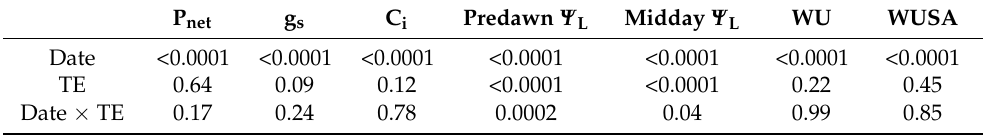
Table 3. Statistical significance for the effects of date and throughfall exclusion (TE) on leaf-level net photosynthesis (P net ), stomatal conductance (g s ), intercellular CO 2 (C i ), predawn leaf water potential ( Ψ L ), midday leaf water potential ( Ψ L ), whole-tree water use (WU), and whole-tree water use per sapwood area (WUSA) for the entire measurement period (2013–2014). Bold values indicate significance at p < 0.1.